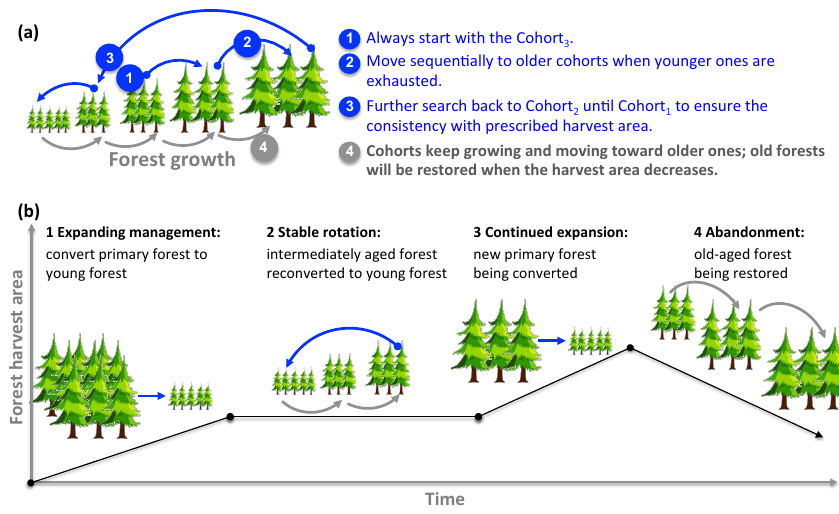
Figure 5. Rules of selection of forest cohorts in secondary wood harvest to account for the dynamics in harvest area over time. (a) Rules of selection of forest cohorts (blue arrows). Clear-cut harvest (1) first starts with intermediately aged cohort, then moves to older cohorts until the oldest one; (2) if the prescribed harvested area still cannot be satisfied, then the harvest will move back to the even younger cohorts (3) to the youngest one until the prescribed harvested area is fulfilled. Independent of the harvest activity is the movement of forests from younger cohorts to older ones because of growth (grey arrows). (b) Example of cohort dynamics along with temporal changes in the harvest area shown in the black curve: (1) before the onset of any harvest activity (i.e. after the model spin-up), only the oldest cohorts are available so harvest starts with the primary forest; (2) for a stable harvest area, a steady-state cycle involving only secondary forest is established (intermediate secondary cohorts being harvested is represented by the blue arrow, and younger growing cohorts are represented by grey arrows); (3) then with an increase in harvest area, more primary forests are harvested; (4) finally, in this example, the harvest area decreases, and older cohorts are